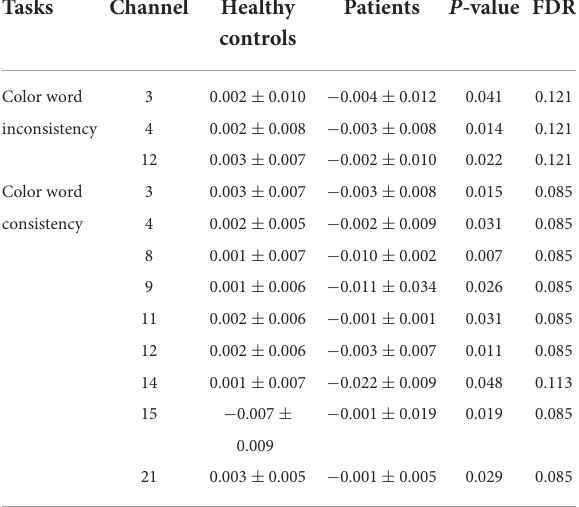
TABLE 3 The β values during Stroop tasks in patients and healthy controls. Tasks